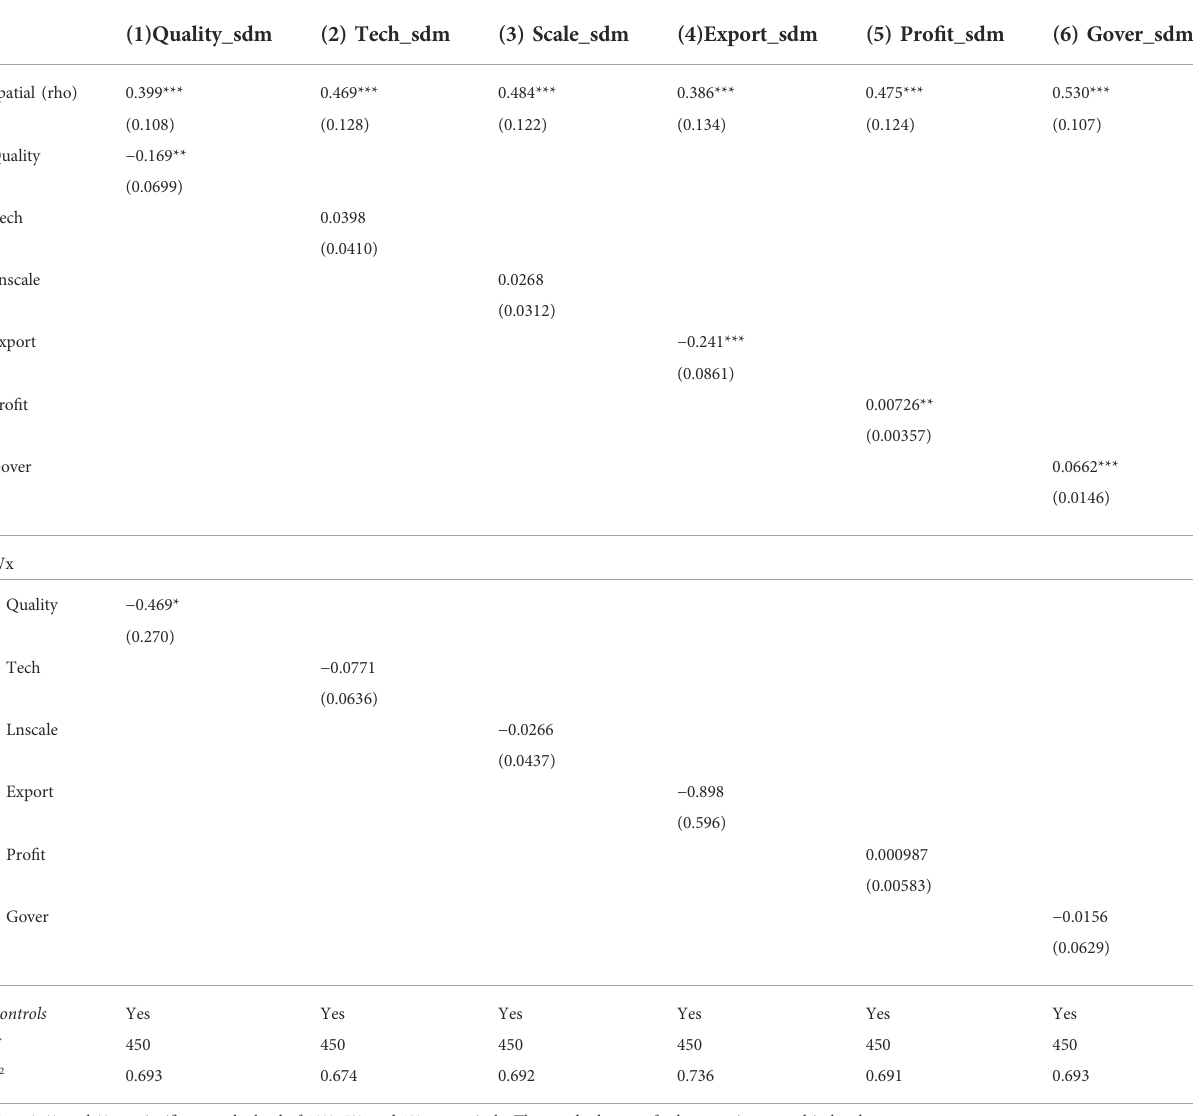
TABLE 9 SDM regression